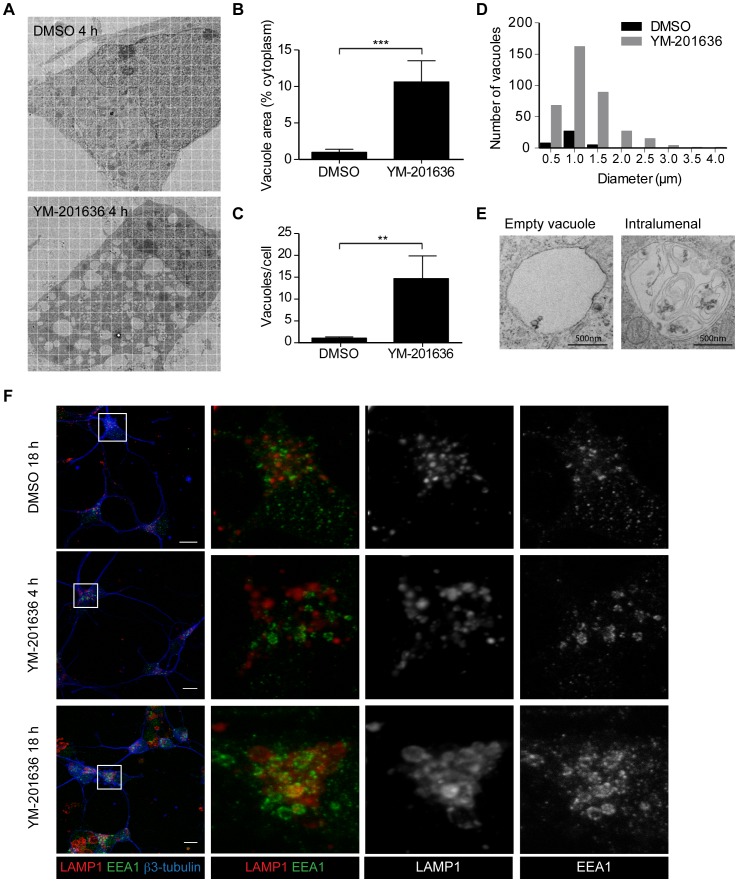
YM-201636 promotes vacuolation and endosomal compartments in hippocampal neurons.(A) Primary hippocampal neurons were treated with DMSO or 1 µM YM-201636 for 4 h and processed for electron microscopy. Images show neuronal cell bodies at the level of the nucleus, demonstrating vacuolation in the presence of YM-201636. Grid size = 1 µm square. (B-D) Electron microscopic analysis of the vacuole area as a percentage of total cytoplasmic area (B) and the number of vacuoles per cell (C) shows a significant increase in vacuole size and number following 4 h treatment with 1 µM YM-201636, **p<0.01, ***p<0.001. (D) Histogram of number of vacuoles relative to their size (representative experiment), n = 12 (DMSO) or 11 (YM-201636) cells. (E) Examples of vacuole phenotypes detected in primary hippocampal neurons treated with 1 µM YM-201636 for 4 h. (F) Primary hippocampal neurons were treated with DMSO or 1 µM YM-201636 for 4 h or 18 h and immunolabelled for LAMP1, EEA1 and ß3-tubulin. 3D projections are shown. Scale bar = 10 µm.